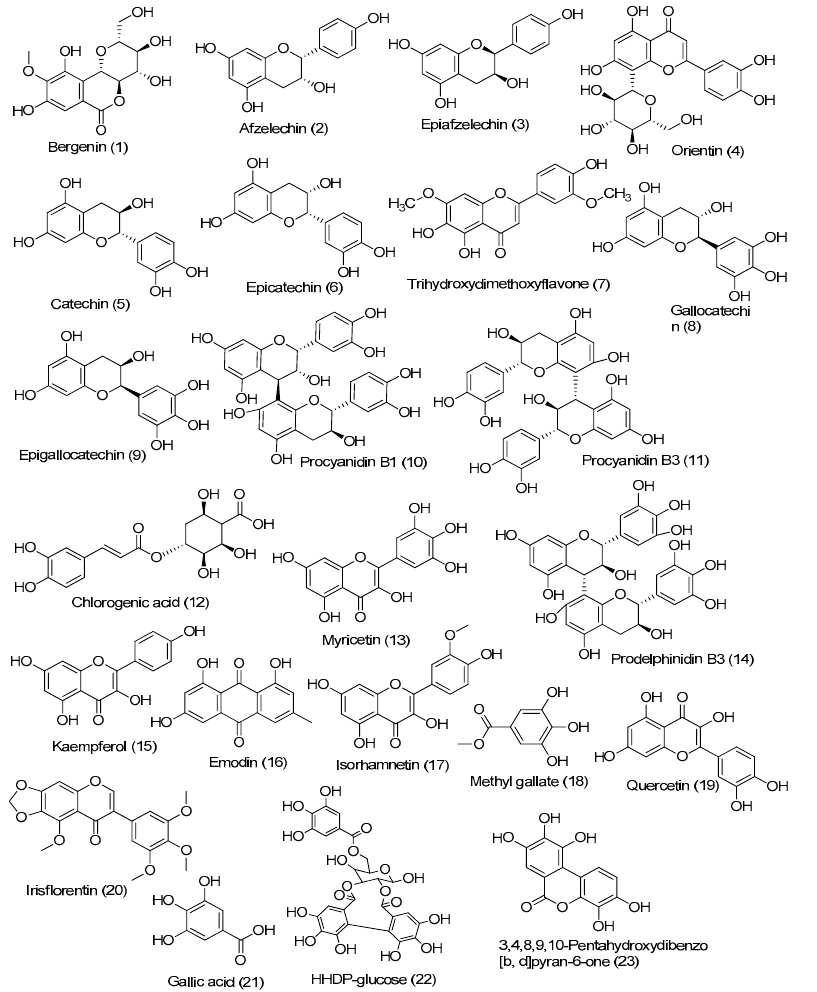
Figure 4. Chemdraw structures of secondary metabolites identified from B. ciliata , M. pudica , and P. emblica through mass